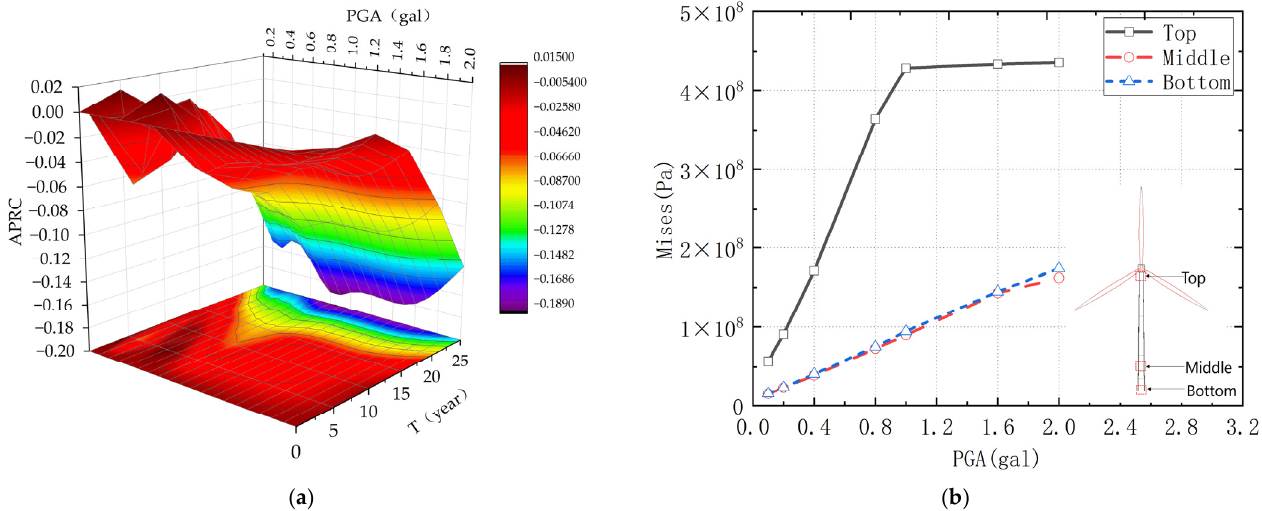
Figure 13. The El Centro earthquake: ( a ) structural APRC value; ( b ) maximum Mises stress.